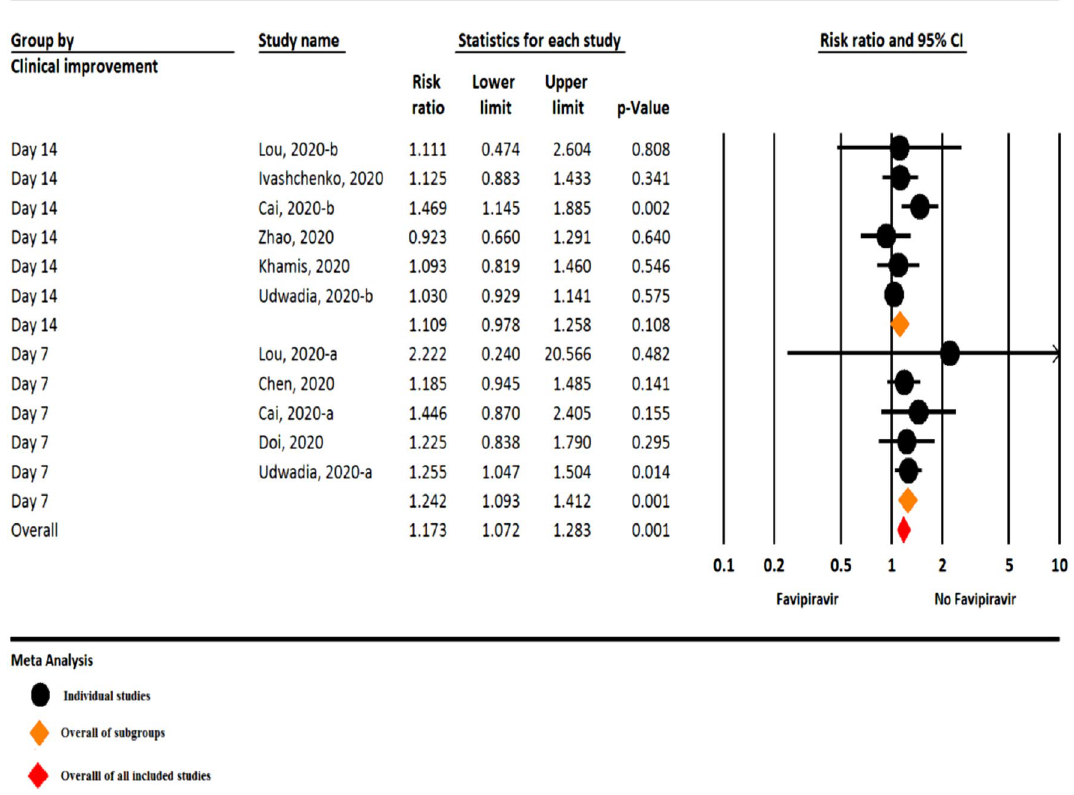
Figure 2. The meta-analysis of clinical improvement of Favipiravir on COVID-19 patients (black circle: individual studies; orange diamond: overall of subgroups; red diamond: overall of all included studies).